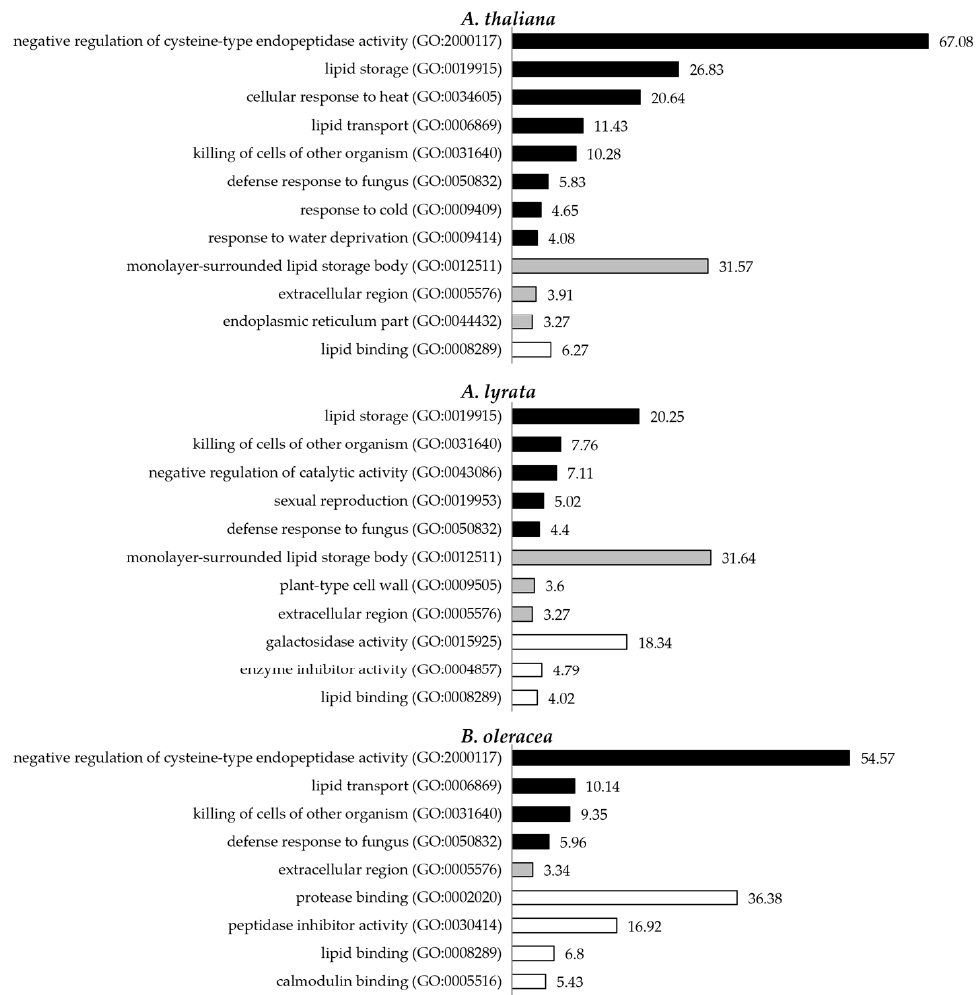
Figure 2. Gene ontology (GO) enrichment analyses of the pollen coat proteomes of A. thaliana , A. lyrata , and B. oleracea . Numbers beside the bars demonstrate the fold enrichment of GO terms over the expected values. Only the categories with fold enrichment >3 and a p -value (determined by Fisher’s exact test) <0.05 are shown. Categories with fold enrichment <3 are shown in Figures S2–S4. Black bars indicate biological processes, grey bars indicate cellular components, and white bars indicate molecular functions.